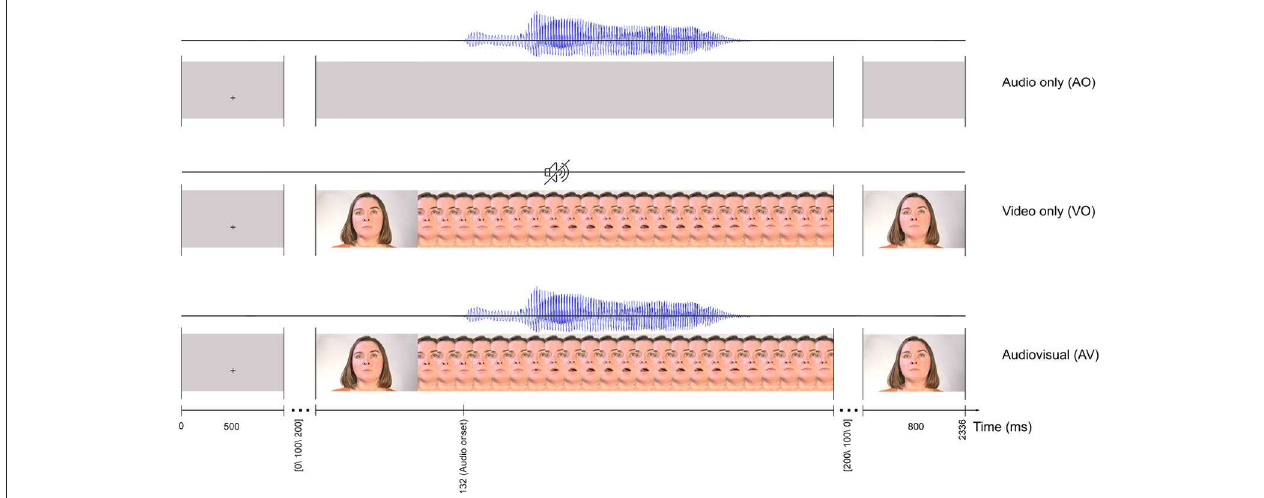
FIGURE 1 | The trial timeline for three conditions: audio only (AO), video only (VO), and audiovisual (AV). All three conditions start with a 500 ms fixation cross and finish with a 800 ms still image as the last frame. Each frame in the figure represents two frames in the actual stimuli.